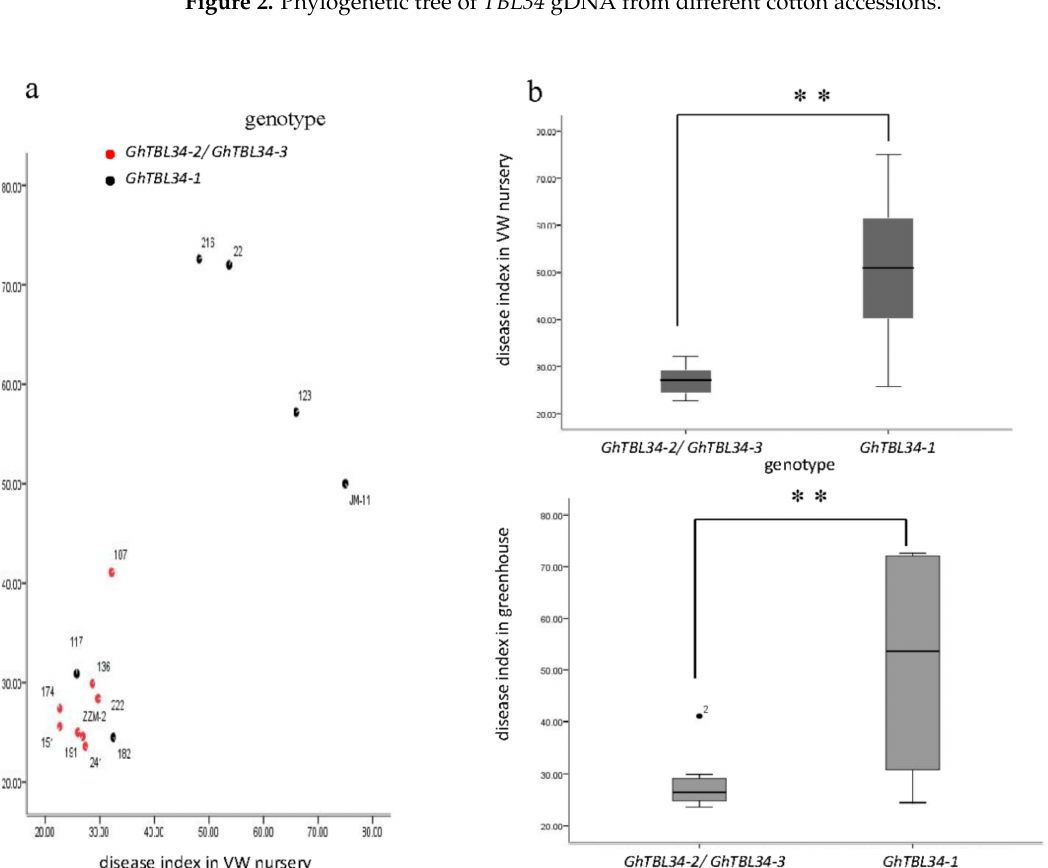
Figure 2. Phylogenetic tree of TBL34 gDNA from different cotton accessions.